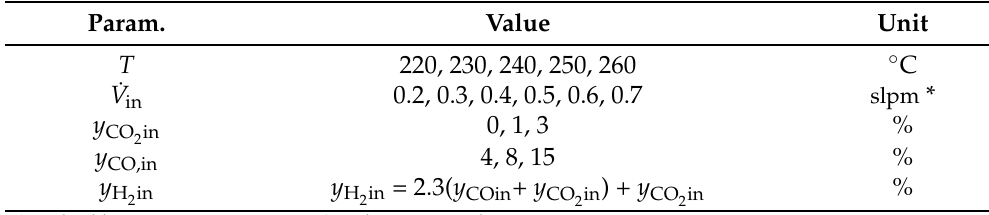
Table 2. Conditions for kinetic measurements [15].